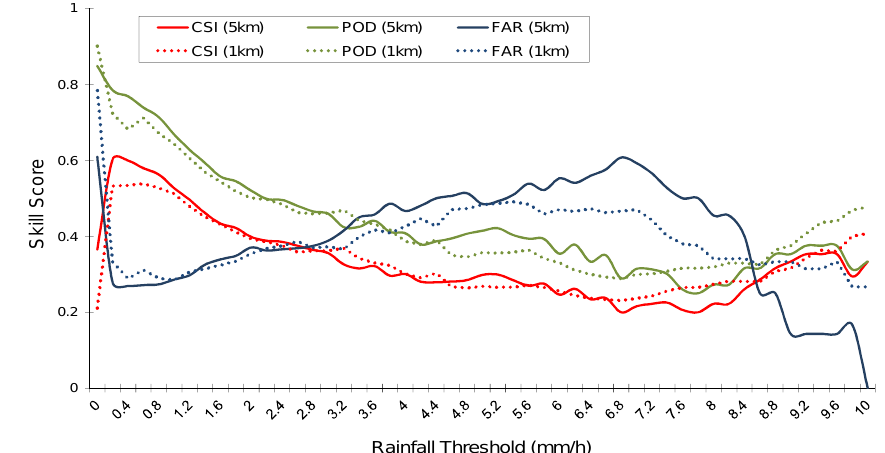
Fig. 7. The skills of radar rainfall estimates against raingauge